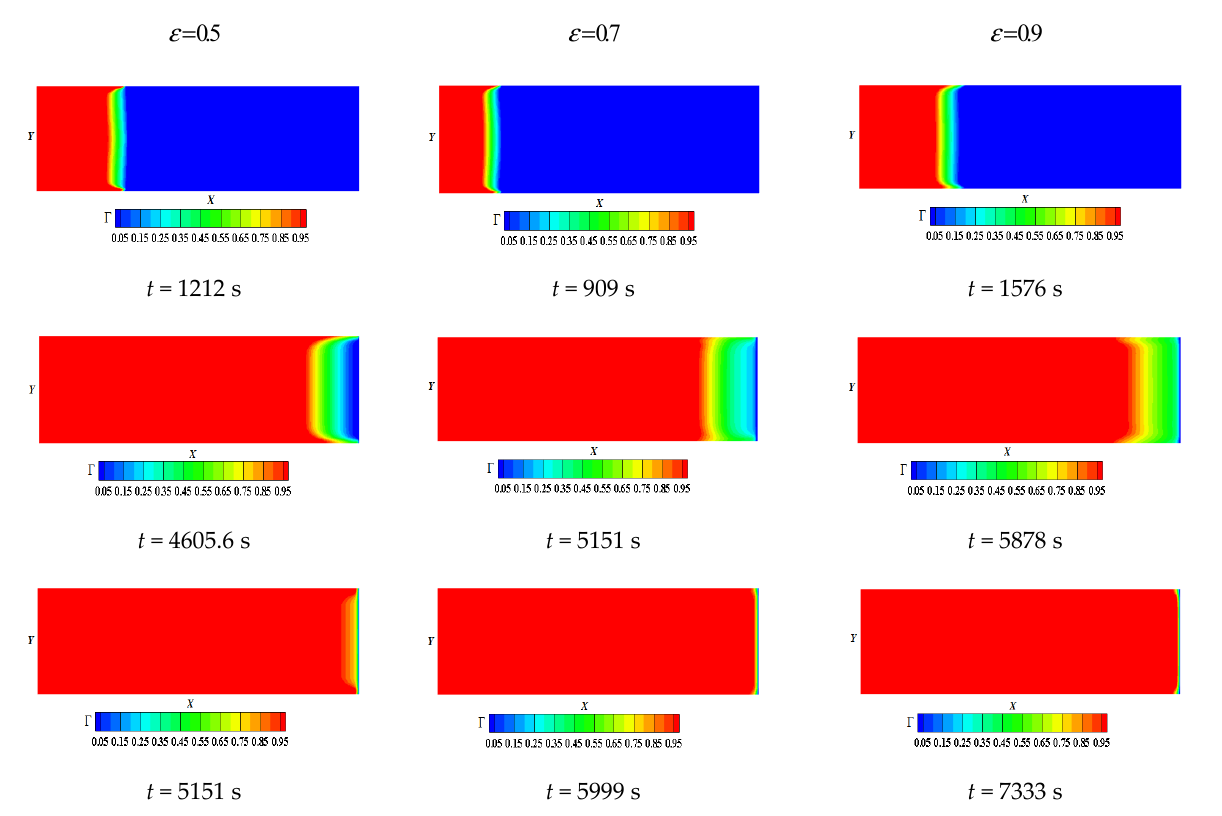
( b ) Figure 18. Reynolds number effect on temperature contours ( , f